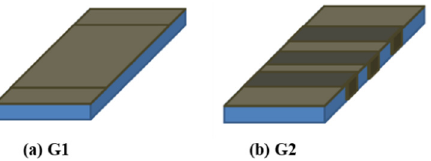
Figure 4. Sketches of renovated FFRP-CFRC slabs: ( a ) G1 and ( b ) G2.